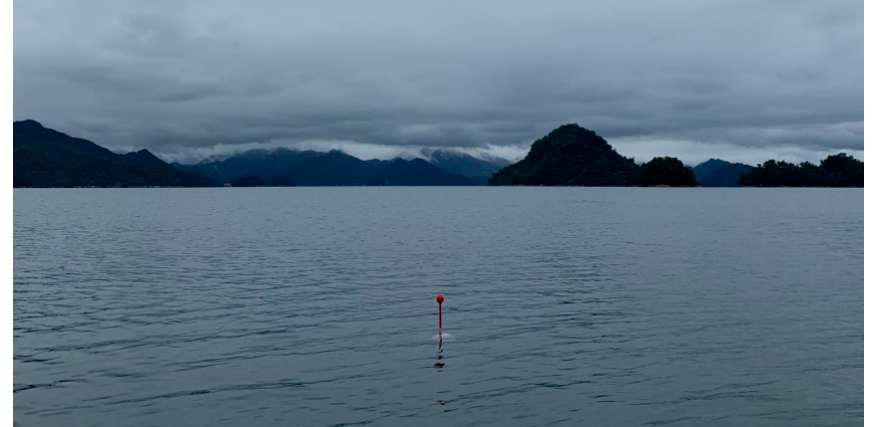
Figure 10. Lake trial conducted at Qiandao Lake.